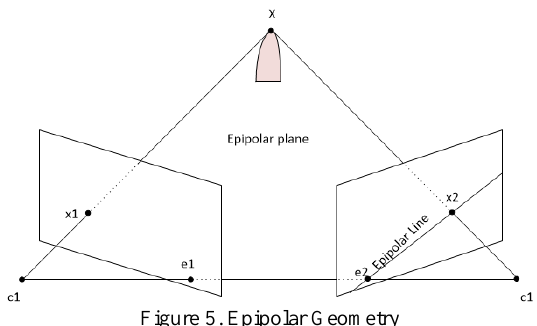
Figure 5. Epipolar Geometry